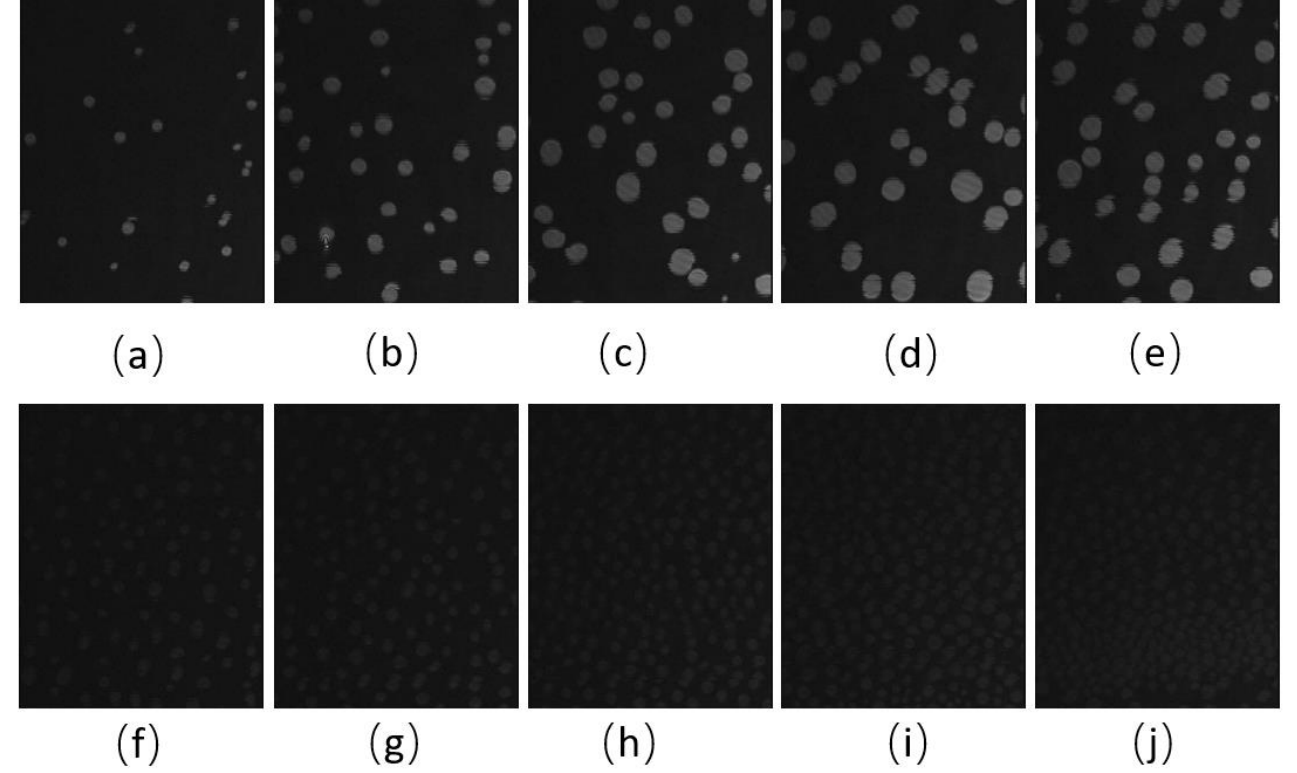
Figure 5. ( a – j ) BAM images (220 µm wide) of CO:GT:FFA:PC 40:25:15:20 (quaternary mixture) film before ozone exposure ( a – e ) and after ozone exposure ( f – j ) at surface pressures of 5 mNm -1 , 9 mNm - 1 , 13 mNm -1 , 16 mNm -1 and , 18 mNm -1 on PBS at 22 °C.